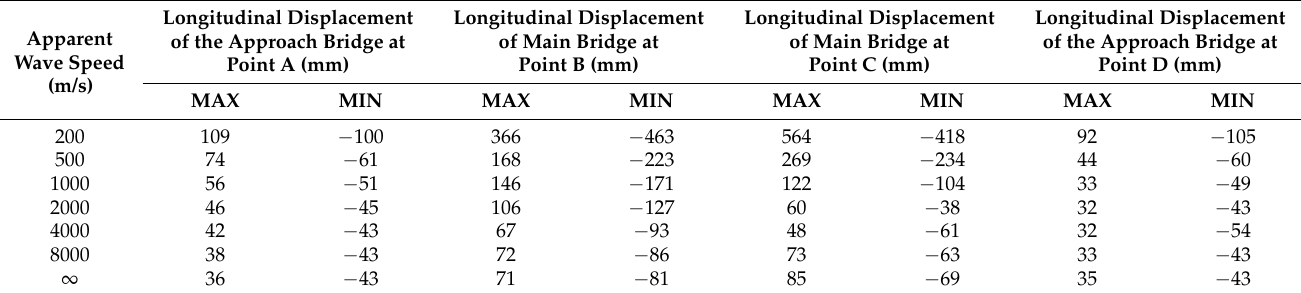
Table 7. Longitudinal displacement of beam end at different apparent wave